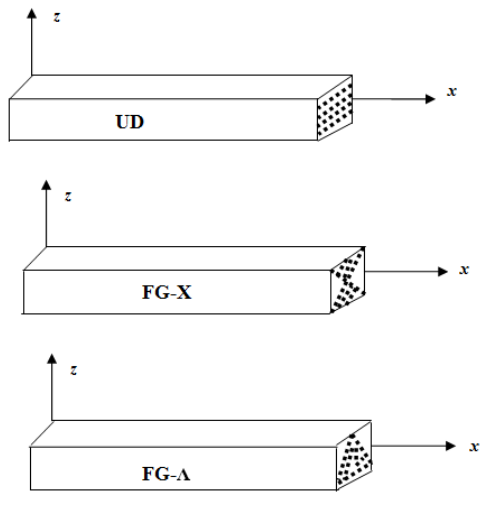
Figure 2: Configurations of the CNTRC in composite